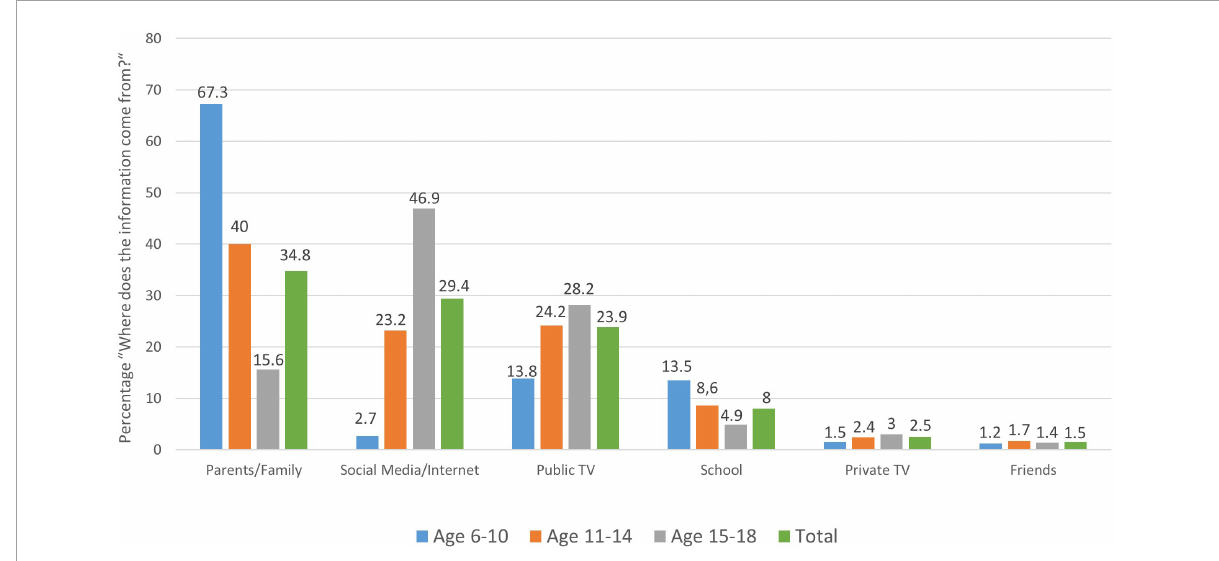
FIGURE3 Distribution of children’s and adolescents’ responses to the question: “Where do you mainly get your information about the coronavirus from”, by age group.